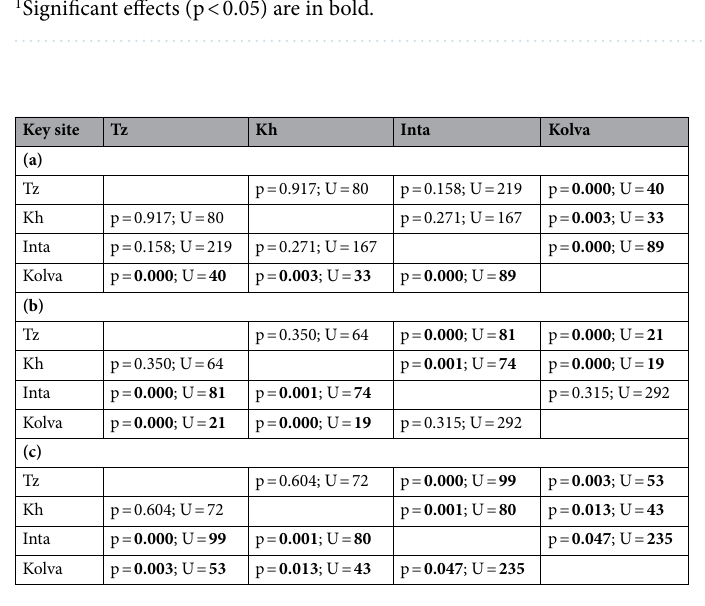
Table 2. Mann–Whitney U-test for (a) 2–4 nuclear PAH, (b) 5–6 nuclear PAH, (c) total amount of PAHs. p < 0.05 are in